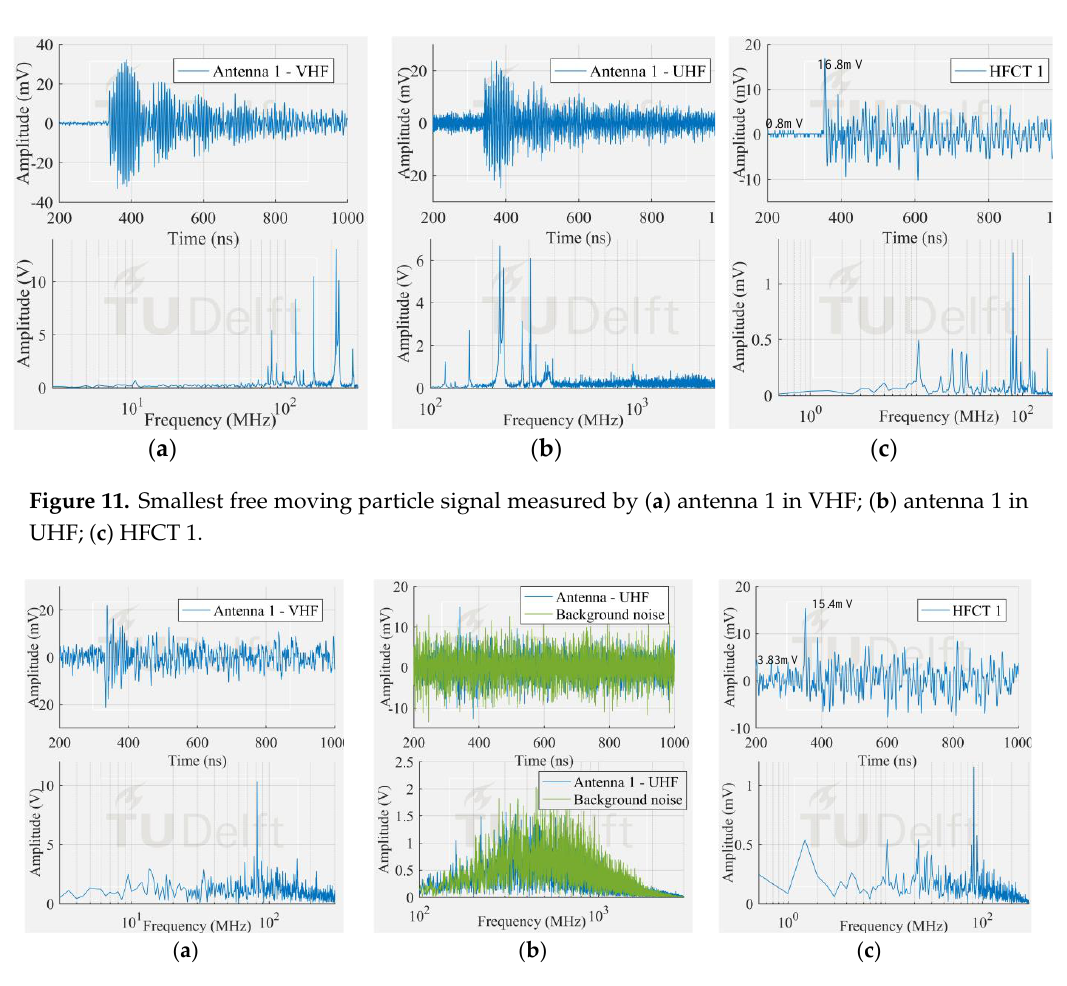
Figure 12. Smallest surface signal measured by ( a ) antenna 1 in VHF; ( b ) antenna 1 in UHF; ( c ) HFCT 1. The surface test case was similar to the corona test case. The measured frequency content of the surface discharge is significant up to around 100 MHz, and as a result, the antenna 1 in VHF picked up the discharge signal but not in UHF range. On the other hand, the free particle discharge produced a frequency spectrum that extended mainly up to 400 MHz, also with a frequency peak at 950 MHz. This broader frequency spectrum resulted in the discharge signal being picked up both in VHF and UHF range.